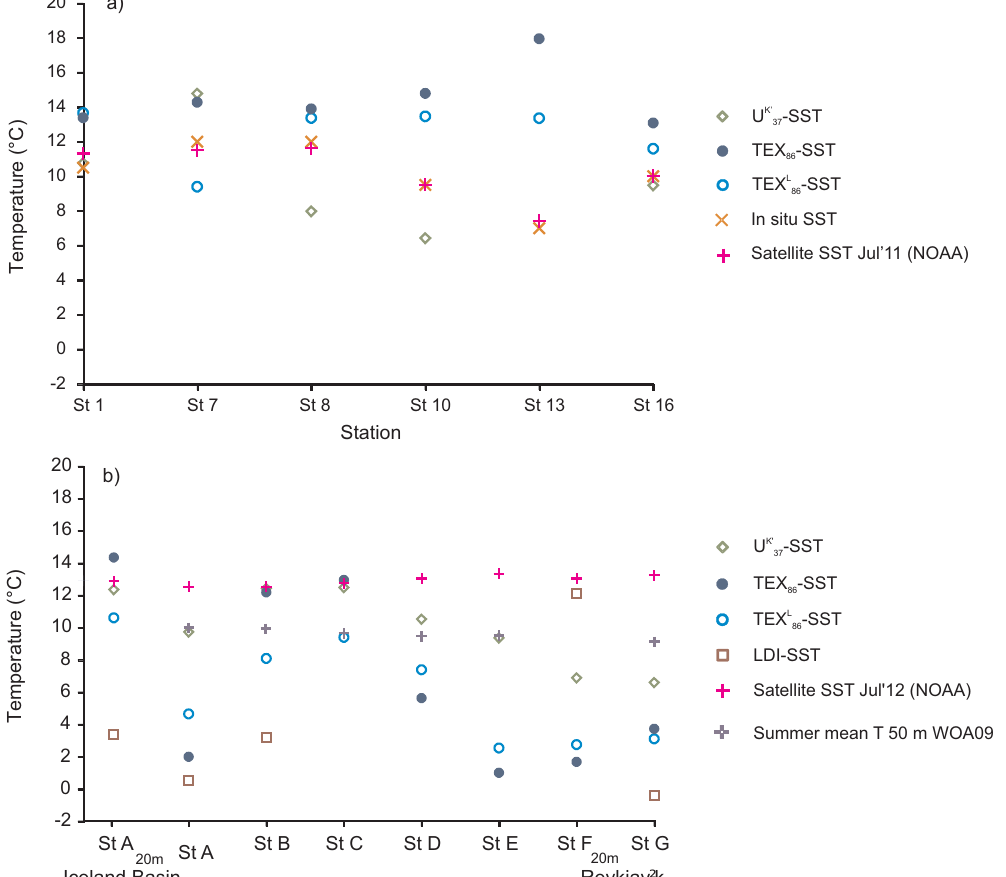
(cid:48) Figure 2. U K -, TEX L - and LDI-derived temperatures from SPM obtained at the different sampling stations around Iceland. Panel (a) : 37 86 SPM collected at ca. 5m water depth during July 2011; panel (b) : SPM collected at 50m water depth collected during July 2012. Open (cid:48) green diamonds indicate U K -derived temperatures; filled dark blue circles indicate TEX 86 -derived temperatures using calibration by Kim et 37 al. (2010a); open blue circles indicate TEX L -derived temperatures using calibration by Kim et al. (2010a); open brown squares indicate LDI- 86 derived temperatures. Orange symbols indicate in situ SST measured with the CTD; pink symbols indicate satellite SST from NOAA remote- sensing records at the time of sample collection, i.e., July 2011 and July 2012, and purple symbols indicate summer mean temperatures at 50m water depth from the WOA09 (World Ocean Atlas)